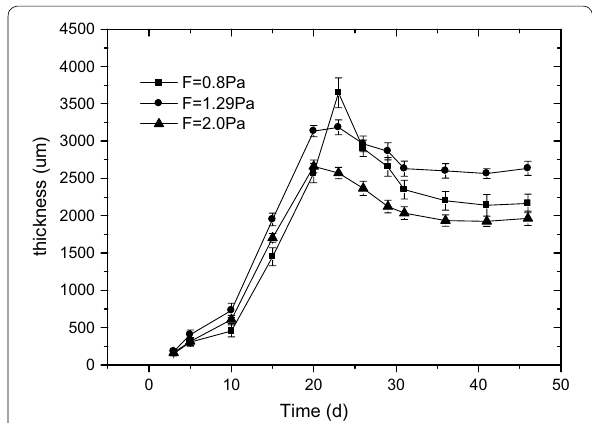
Fig. 2 Biofilm thickness versus time at different wall-shear stresses, COD 400 mg/L (F means wall-shear stress, Pa). At different shear = stresses, biofilm thickness changes according to a similar pat- tern. Firstly, biofilm thickness reached a maximum value within 0–25 days. Then, within 5–10 days after the thickness reaches its maximum value, the thickness of the biofilm decreases to a certain extent. Finally, biofilm thickness tended towards stability. Under the conditions of this experiment, the thicknesses of the biofilms were